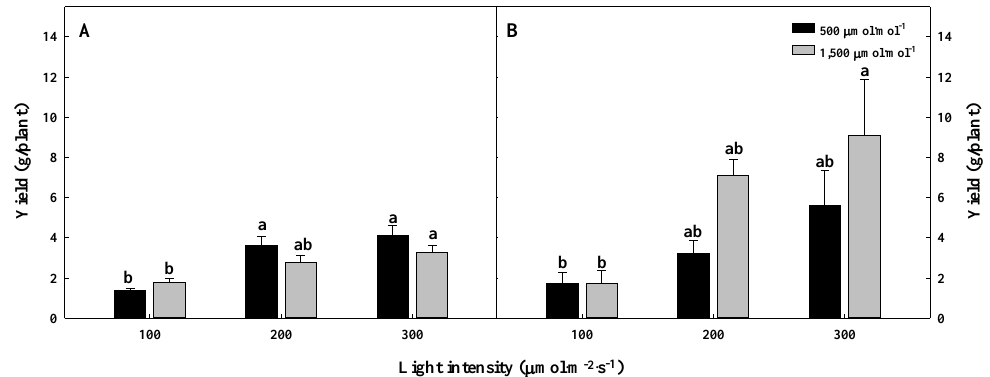
Figure 4. The different first ( A ) and second ( B ) harvest yields of Glehnia littoralis Fr. Schmidt ex Miquel, as affected by various CO 2 concentrations and light intensities after 56 days of treatment. The vertical bars represent the standard deviation of the mean ( n = 3). Different letters above bars indicate significant differences at p ≤ 0.05, using Tukey’s multiple range test.